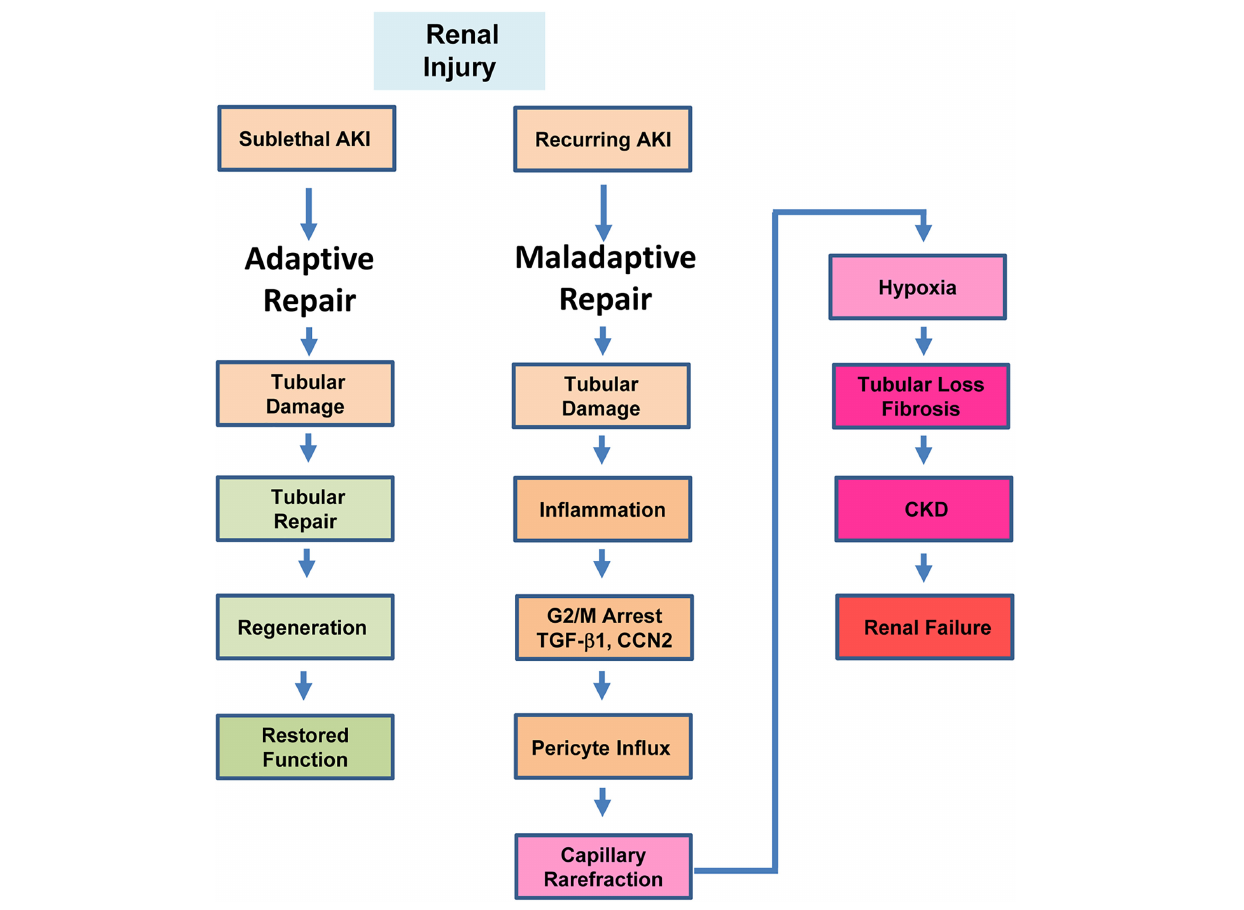
FIGURE 2 | Repair outcomes in the injured kidney. Mild or sublethal AKI initiates a process of adaptive repair that involves resolution of inflammation and restoration of tubular architecture with a regain of renal function. Recurring AKI or severe tubular trauma, in contrast, results in maladaptive repair which is characterized by a sustained inflammatory response, stalling of injured proximal tubular epithelial cells in the G 2 /M stage of the cell cycle, interstitial translocation of vascular pericytes and their differentiation into ECM-producing myofibroblasts, tubular atrophy, capillary loss and failure to regenerate a functional epithelium. G 2 /M-stalled proximal tubular cells express significant levels of the potent pro-fibrotic effectors TGF- β 1 and CCN2 which contribute to the initiation and progression of renal